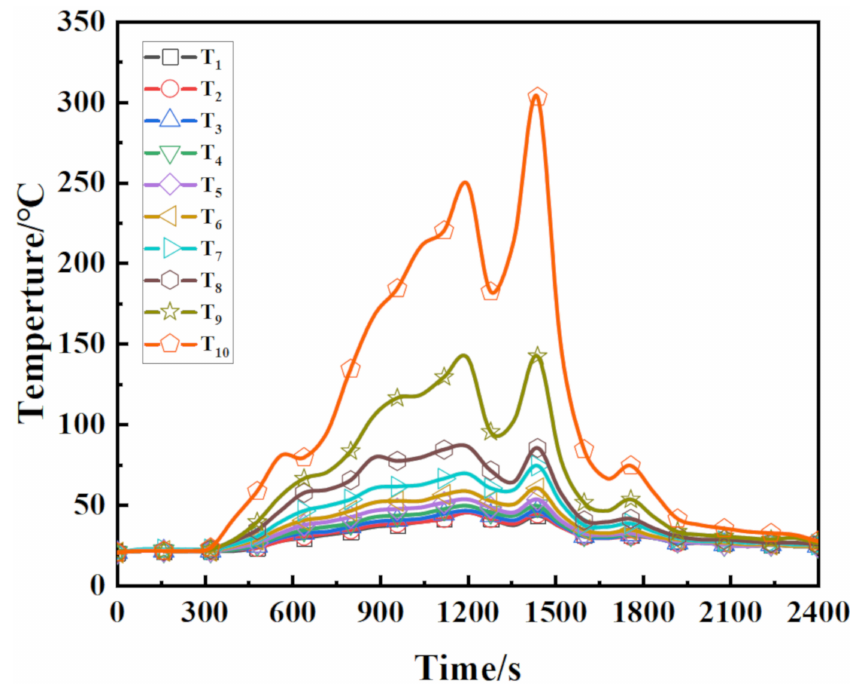
Figure 8. Temperature distribution